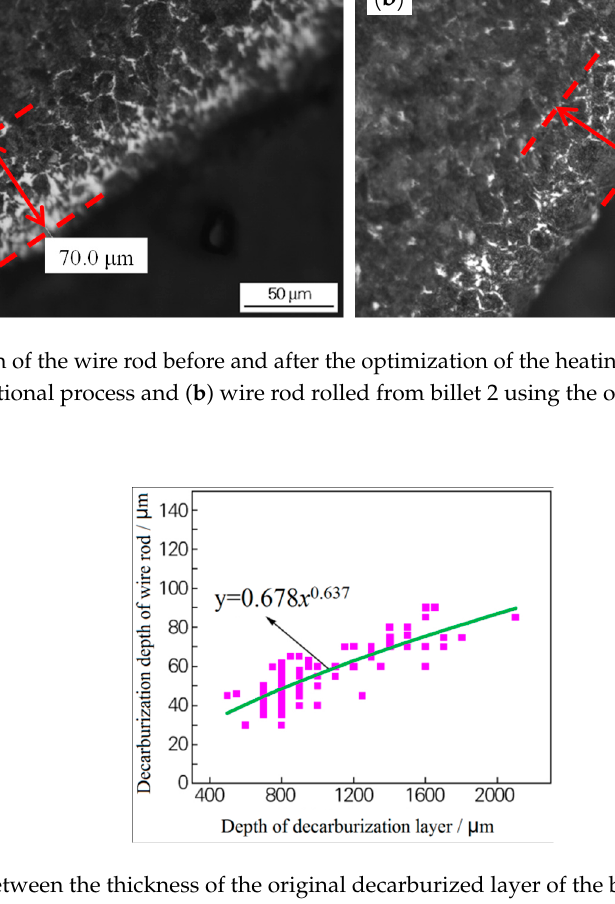
Figure 5. Decarburization of the wire rod before and after the optimization of the heating process: ( a ) wire rod rolled from billet 1 using the conventional process and ( b ) wire rod rolled from billet 2 using the optimized process. Reprinted with permission from ref. [10].